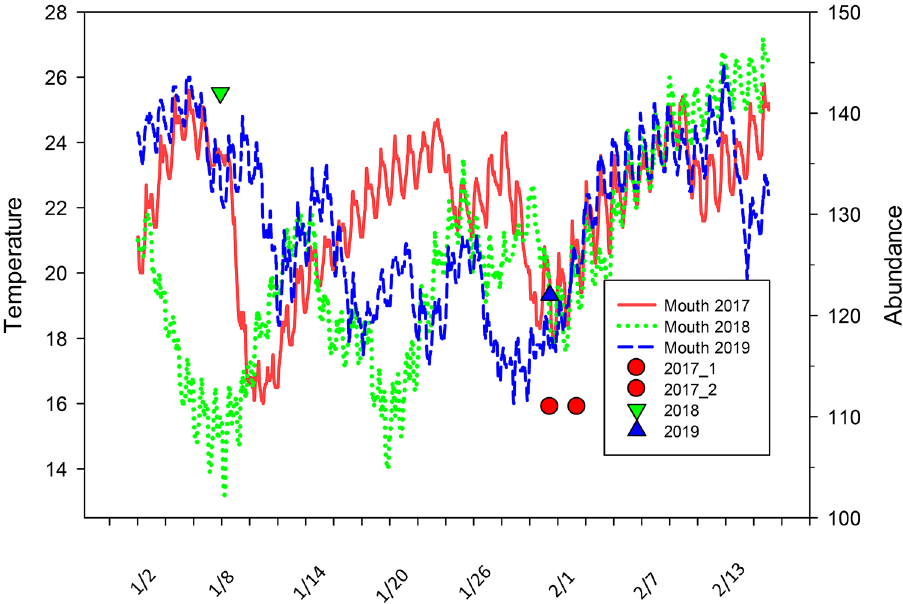
Figure 2. Water temperatures from the mouth of the Faka Union Canal south of the mitigation pools and estimates of manatee abundance during each survey in 2017, 2018 and 2019. Lines indicate water temperature: red line (2017), green dashed (2018) and blue dashed (2019). Shapes indicate the date of the survey and the abundance estimate: red circle (2017), green upside-down triangle (2018) and blue triangle